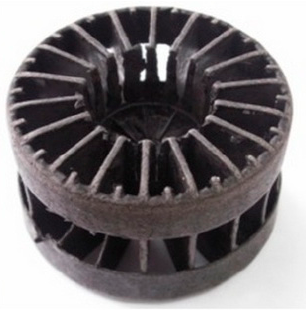
Figure 1. The carrier for activated sludge immobilization as a biofilm. immersed to a depth of approximately 1 m. An average sample from three collected probes was used. Hydrobiological analyses [20] were used to characterize 840 samples of activated sludge and biofilms in seven months. The ranges of ash content, concentration and protein content were determined for the samples (Table 1). Table 1. The characteristics of biofilm and activated sludge samples. Sample